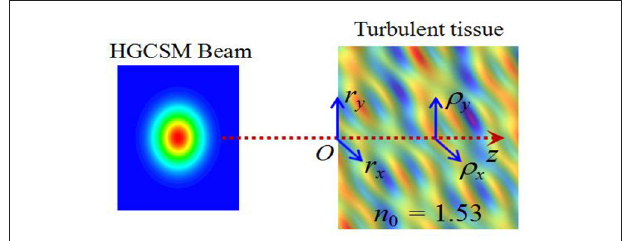
FIGURE 1 | Illustration of the propagation of a HGCSM beam in a turbulence